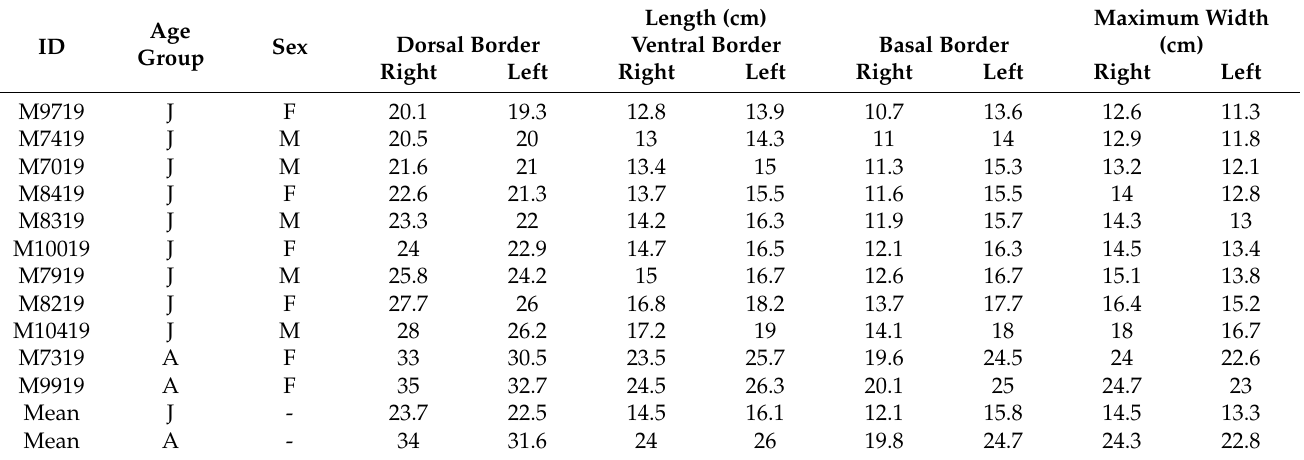
Table 3. Morphometric data of the lungs from the 11 individuals of Arctocephalus australis investigated in the present study. A: adult; J: